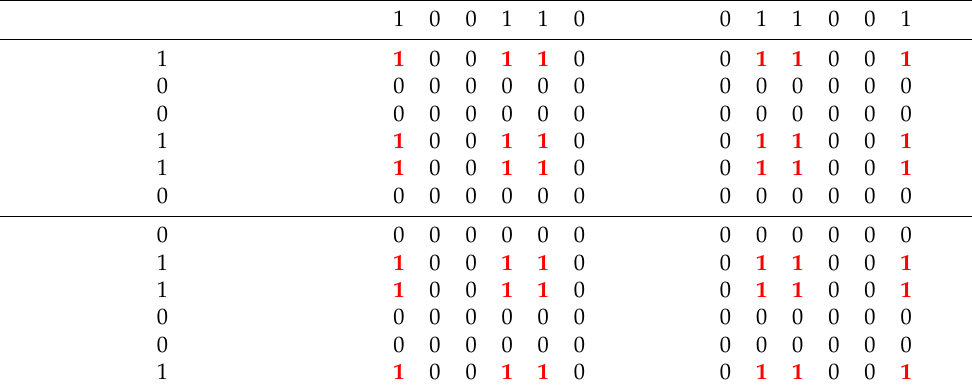
Table 2. 2D-MD code time spreading description.